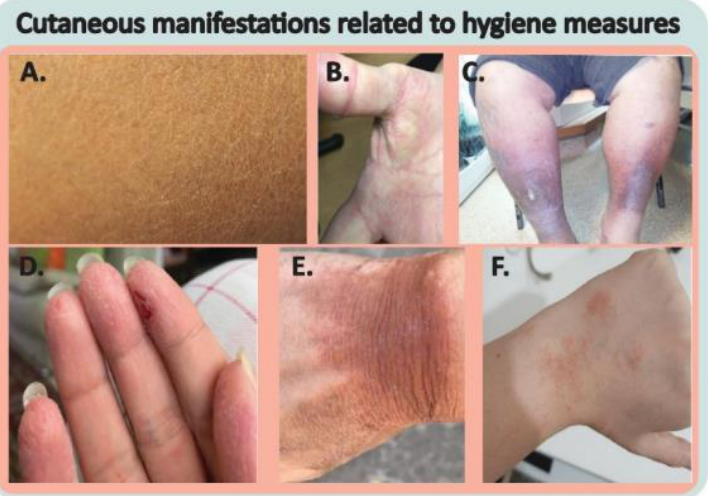
Figure 4. Cutaneous manifestations related to preventative measures implemented for COVID-19 pandemic. Xerosis ( A ) and irritant contact dermatitis ( B ) due to frequent handwashing/alcohol- based sanitizers, ( C ) stasis dermatitis due to sedentary behavior mandates, ( D , F ) eczematous contact dermatitis, ( E ) post-inflammatory hyperpigmentation related to severe disinfectant-related dermatitis. Images adapted from